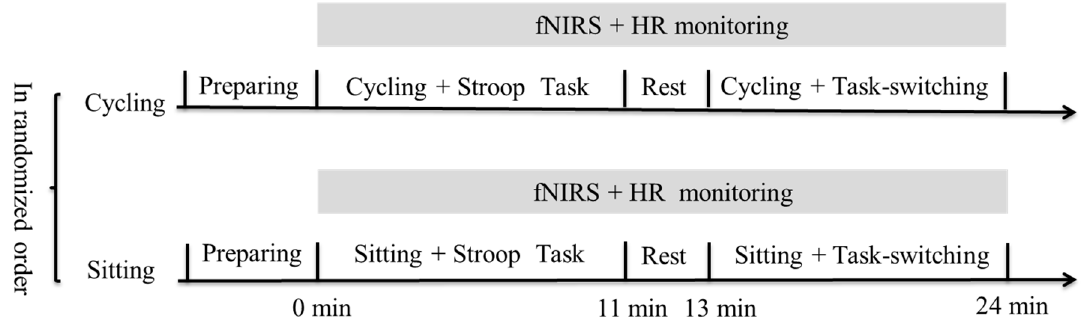
Figure 1. Chart of experimental design and protocol.